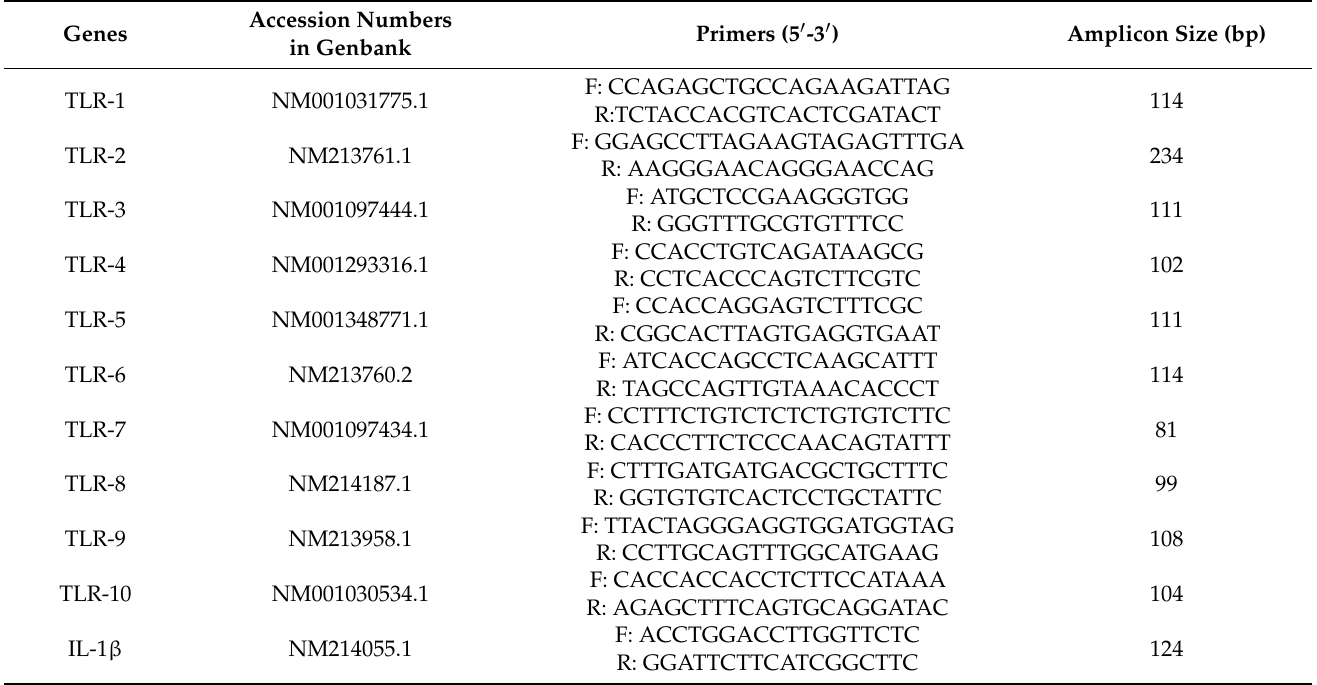
Table 1. Primers for expressions of TLRs, cytokines, and cytokine receptors in this